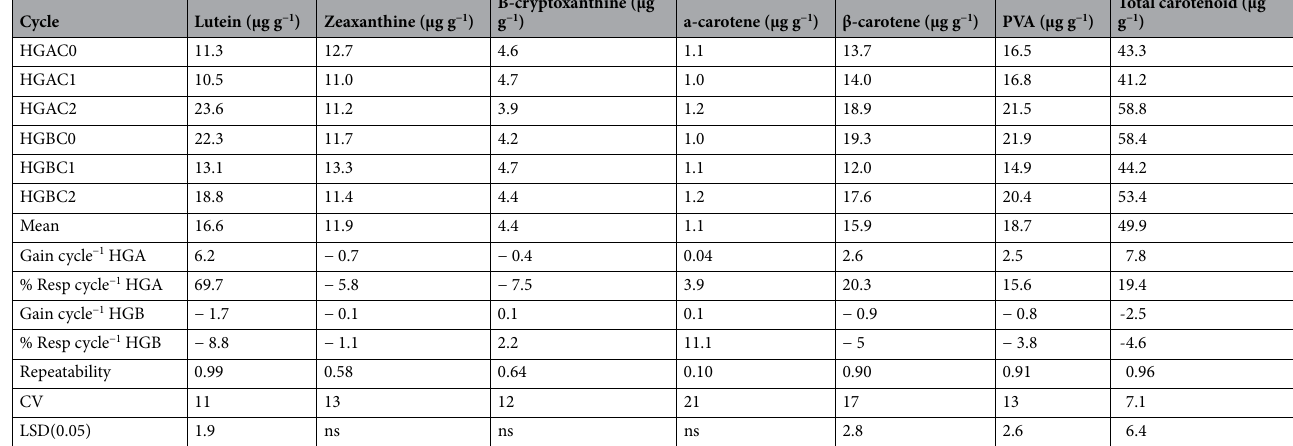
Table 3. Means and genetic gains for PVA and other carotenoids of HGA and HGB and their derived cycles improved through marker assisted recurrent selection. Resp response, ns non-significant.